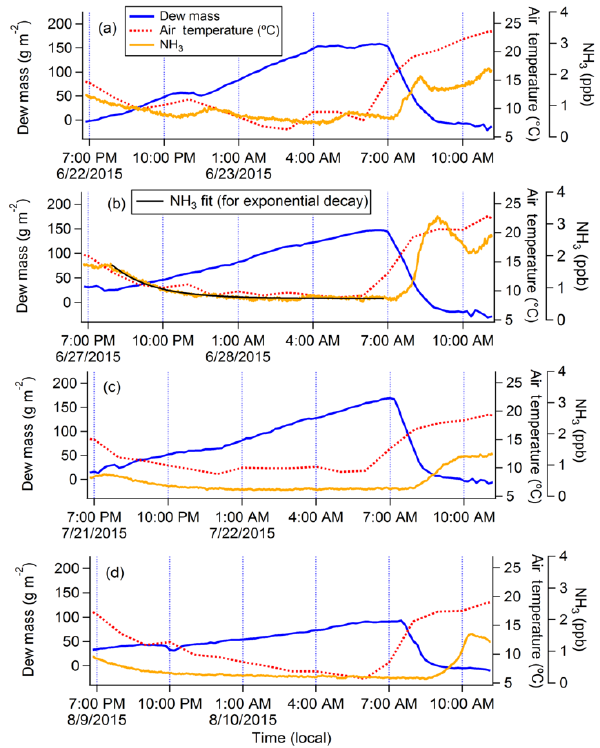
Figure 3. Dew accumulation (blue, gm − 2 ) , NH 3 mixing ratio (or- ange, ppbv), and air temperature (red, ◦ C) overnight on (a) 22 June, (b) 27 June, (c) 21 July, and (d) 9 August 2015. The black line in (b) is the best fit for the NH 3 mixing ratio to an exponential decay function (see Eq. 4) between 20:00 and the onset of dew evapora- tion.